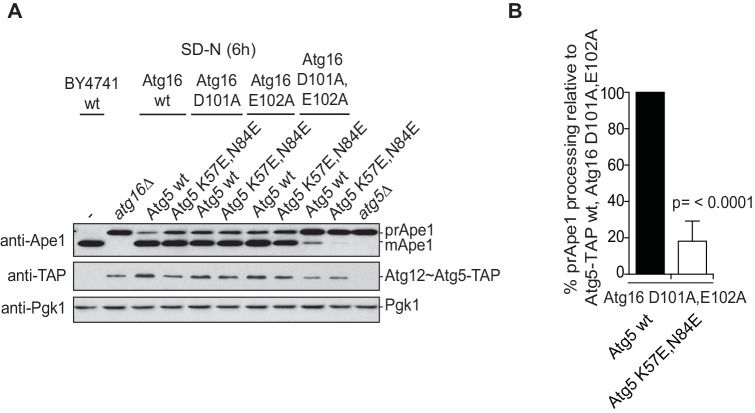
The Cvt pathway is affected upon disrupting Atg19 – Atg5 interaction.(A) prApe1 processing assay using yeast atg16Δ strain with Atg5-TAP or Atg5 K57E,N84E-TAP stably integrated in the genome and transformed with the indicated Atg16 constructs. The blot shows the full set of Atg16 mutants after 6 hr nitrogen-starvation. The Ape1 bands were detected using anti-Ape1 antibody. The bar graph in (B) shows quantification of the prApe1 processing of four independent experiments. The p-value was calculated using a two-tailed Student t-test.